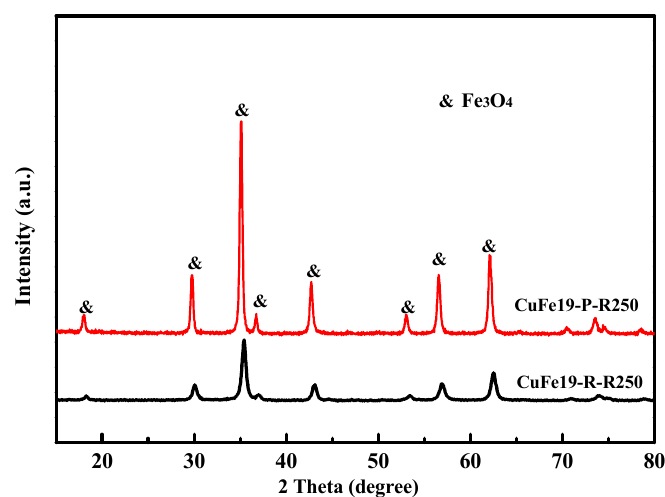
Figure 5. XRD patterns of CuFe19-P and CuFe19-R reduced at 250 ◦ C for 3 h.